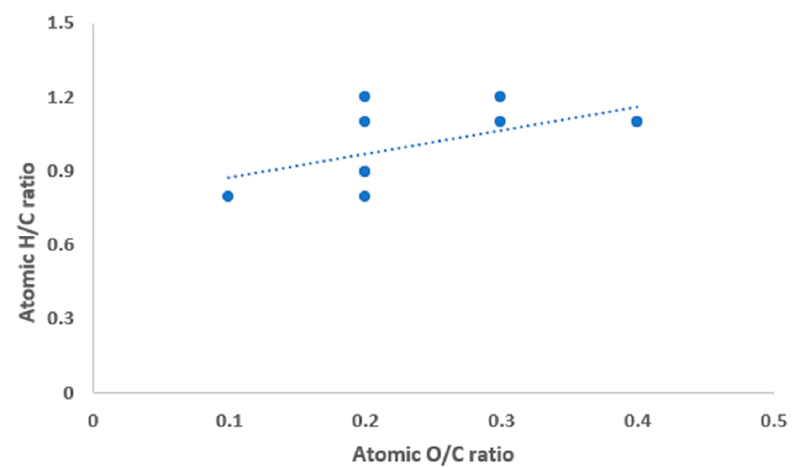
Figure 5. Van Krevelen diagram of untreated and WSS biochar.